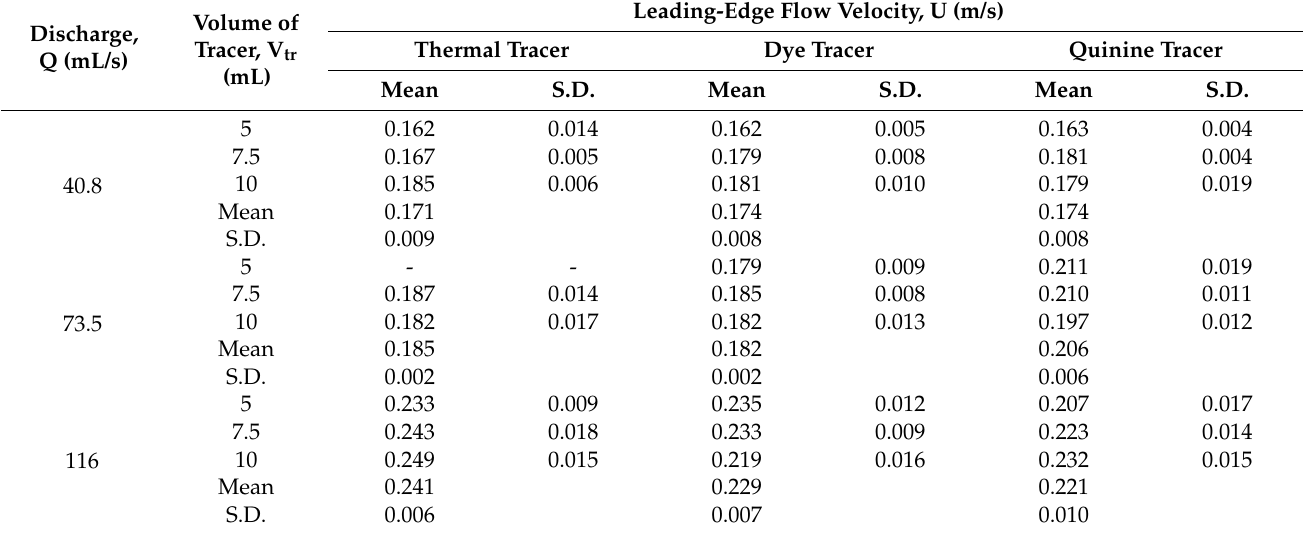
Table 2. Eroded surface flow test results for thermal, dye and quinine fluorescent tracer leading-edge velocities, for different discharges and tracer volumes. The data are for three replicates of each combination. Notation “-“ means no